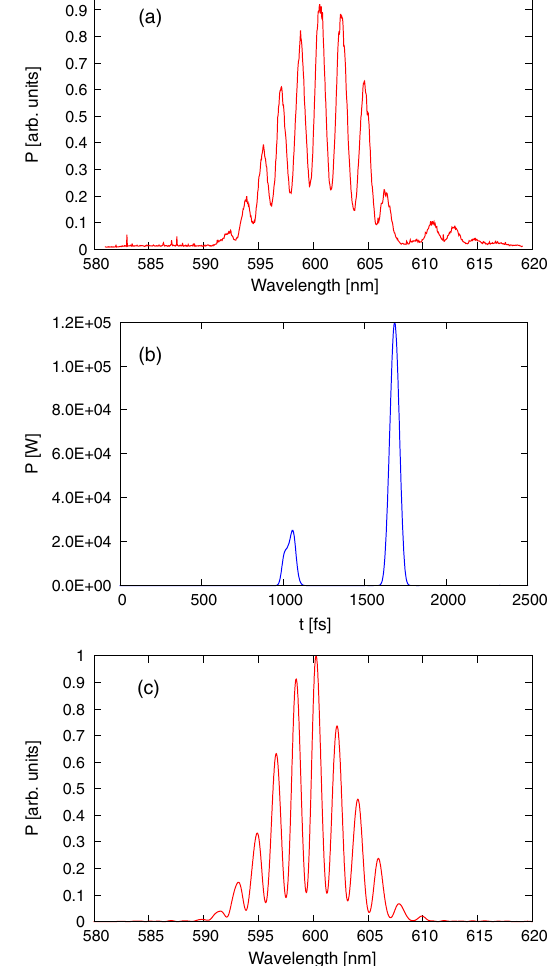
FIG. 6. Radiation pulses and corresponding spectrum after the modulator of the second stage. Two pulses have been generated by R1 and M2, which results in an interference pattern of the spectrum: (a) measured spectrum, (b) simulation result of the pulse structure, and (c) simulation result of the spectrum.